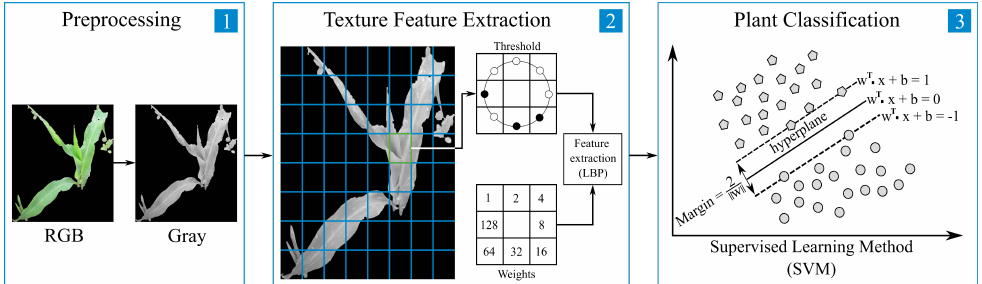
Figure 6. General scheme of the classification approach based on classical machine learning. ( 1 ) Color space change of the input image. ( 2 ) Texture feature extraction of the input image through LBP riu 2 ( 3 ) Classification of texture features through SVM.